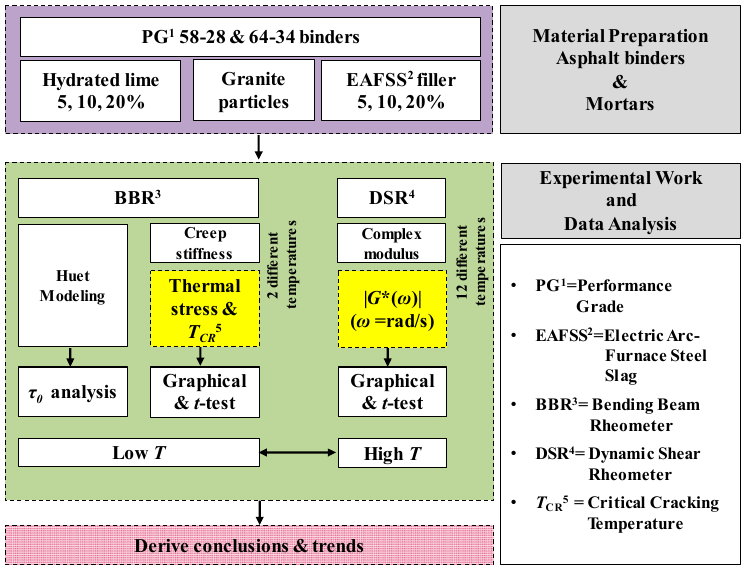
Figure 1. Research approach performed in this study.